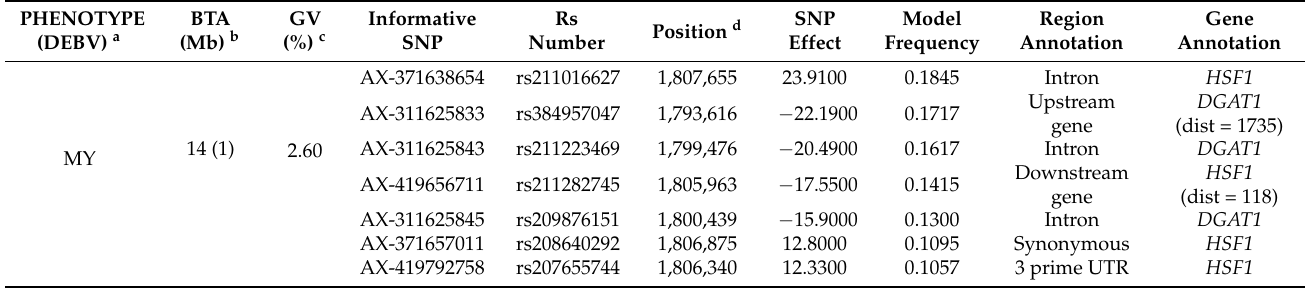
Figure 1. Manhattan plots for genome-wide association studies (GWAS) based on the single marker regression (SMR) and Bayesian C (BayesC) methods. GWAS performed in four phenotypes: ( A , E ) the adjusted 305-day milk yield (MY), ( B , F ) the adjusted 305-day fat yield (FY), ( C , G ) the adjusted 305-day protein yield (PY), and ( D , H ) the log 2 transferred somatic cell score (SCS). Red dots represent significant SNPs or windows on SMR and BayesC, respectively. Table 1. Summary of informative SNPs in the significant 1-Mb windows associated with DEBV phenotypes (MY, FY, PY, and SCS) based on